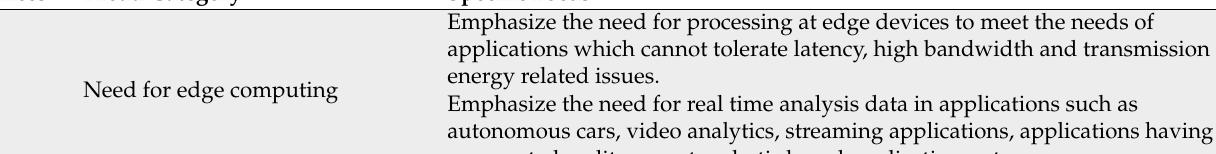
Table 2. Short overview of the relevant